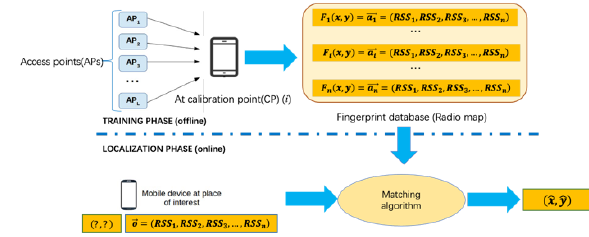
Figure 1. Workflow of Wi-Fi fingerprinting system.